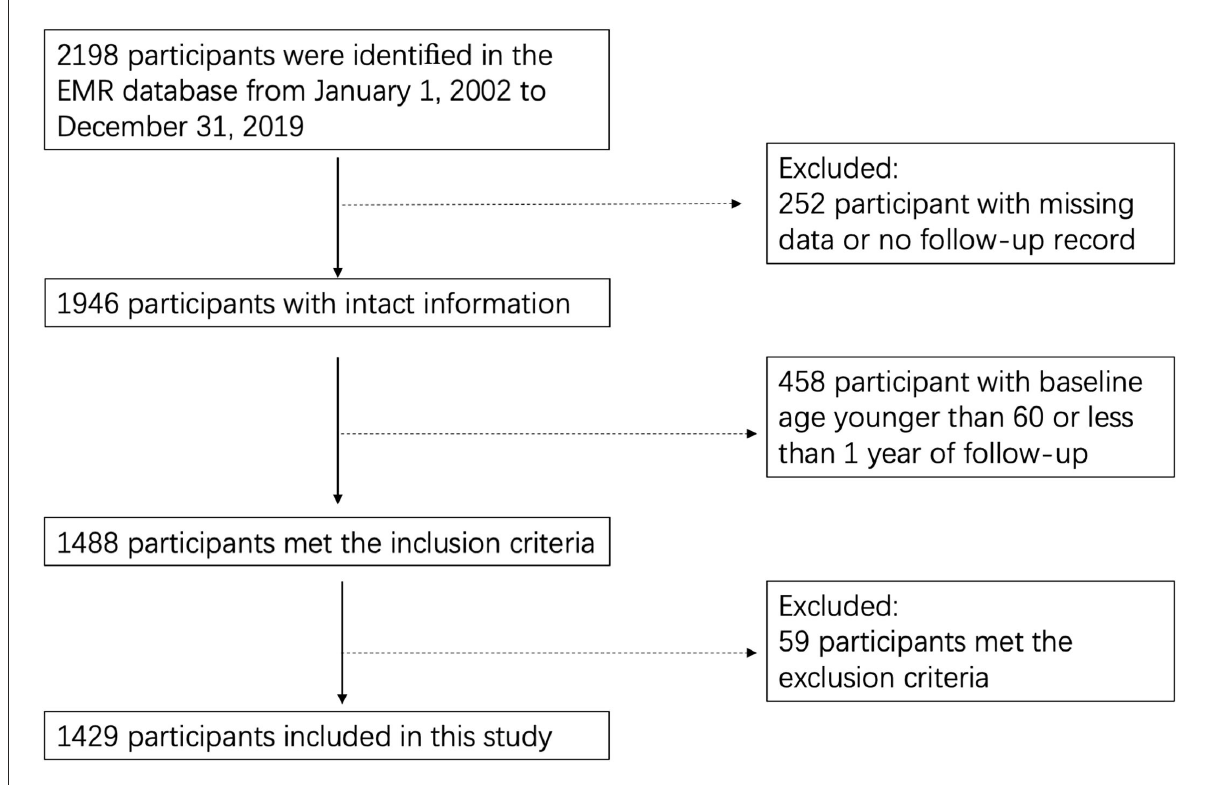
FIGURE1 Flowchart displaying a selection of the study